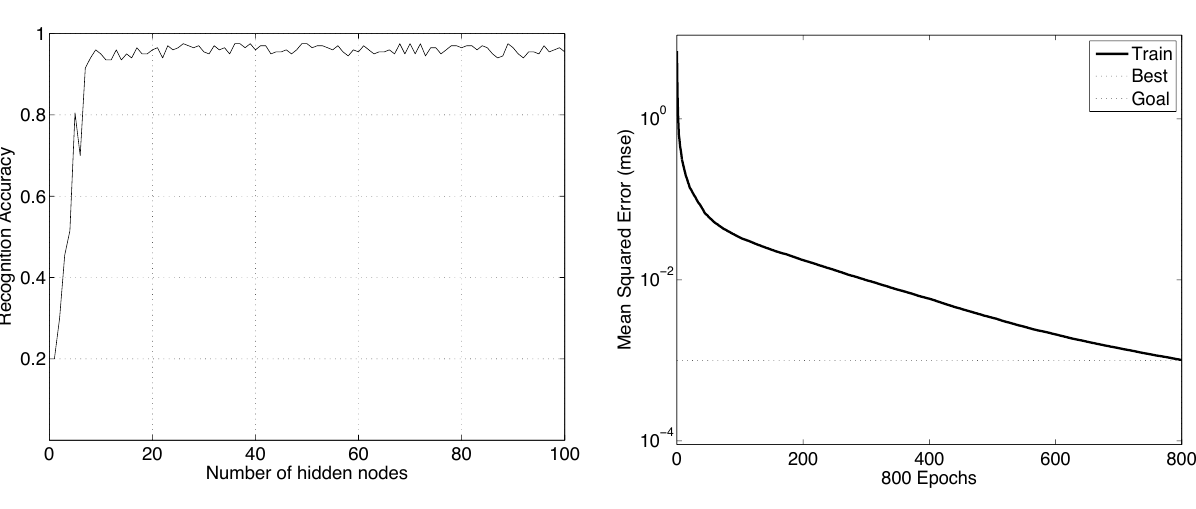
Figure 12. Results of deciding the number of hidden nodes ( left ) and the epoch and goal ( right ) for walking pattern-based identification.